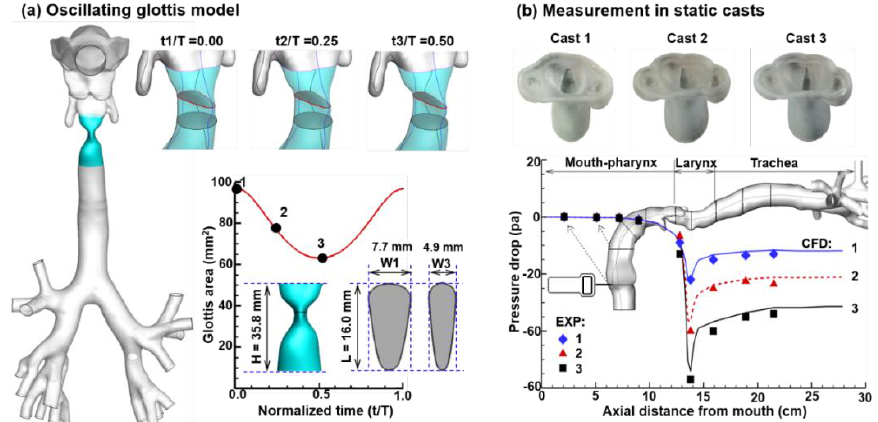
Figure 1. Computational airway model and validation against in vitro experiments: ( a ) Upper respiratory airway model with a rhythmically contracting/expanding glottis, ( b ) model validation against the experimental measurement of pressure in the airway cast with three glottal apertures.